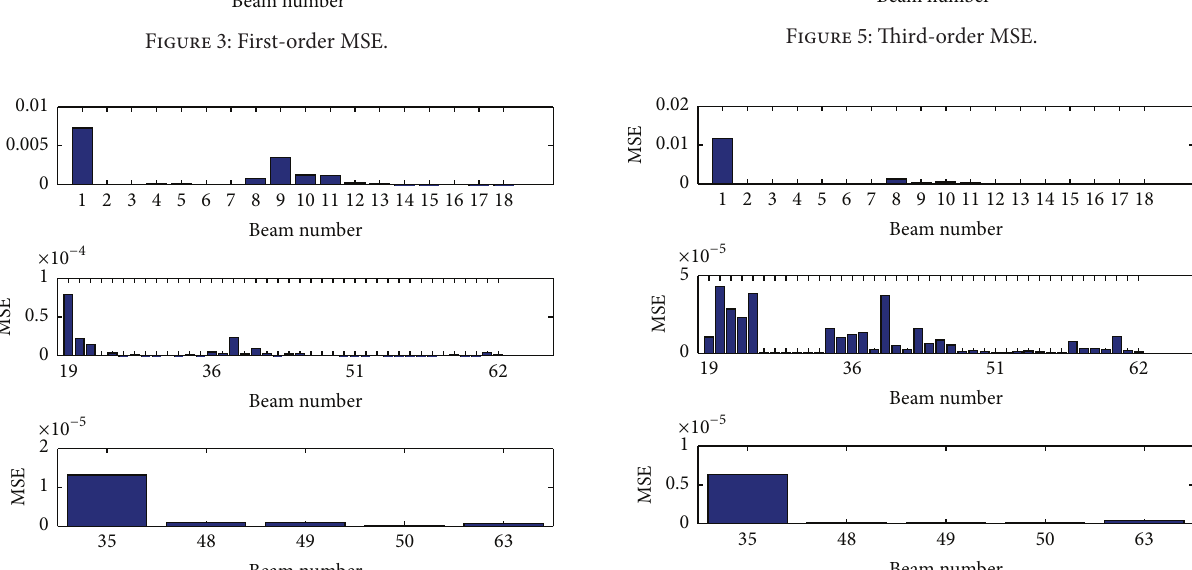
Figure 6: Fourth-order